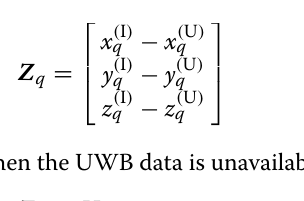
predictive model/ELM in #2 UWB +